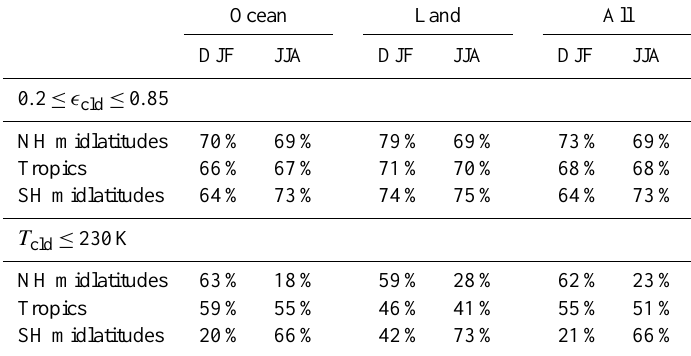
Table 2. Fraction of high clouds kept within cloud emissivity and cloud temperature boudaries for three latitude bands (NH:45 ◦ N–60 ◦